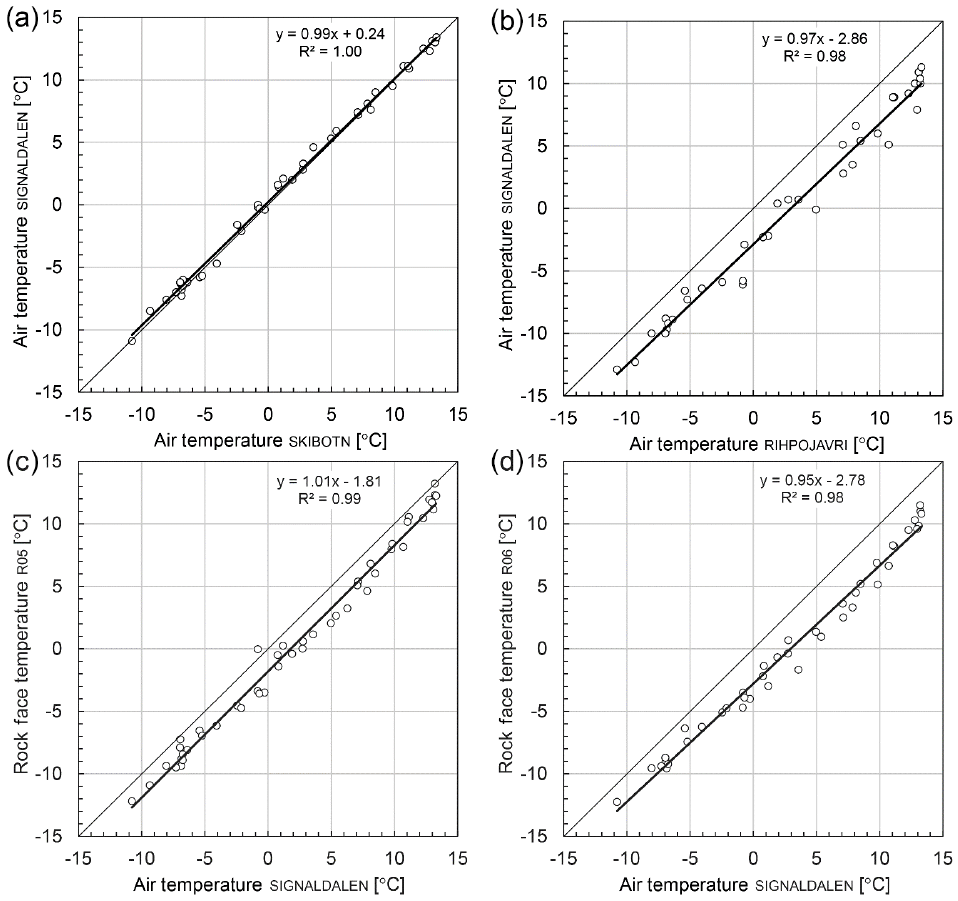
Figure 6. Scatter diagrams showing relations between monthly mean temperature for the main air temperature and rock face temperature series, including linear regression lines. (a) Relation between air temperature in Signaldalen and at meteorological station at Skibotn; (b) re- lation between air temperature in Signaldalen and air temperature measured at Rihpojavri weather station (25km from Signaldalen); (c) and (d) relation between rock face temperature logger sites R05 and R06, respectively, and air temperature in